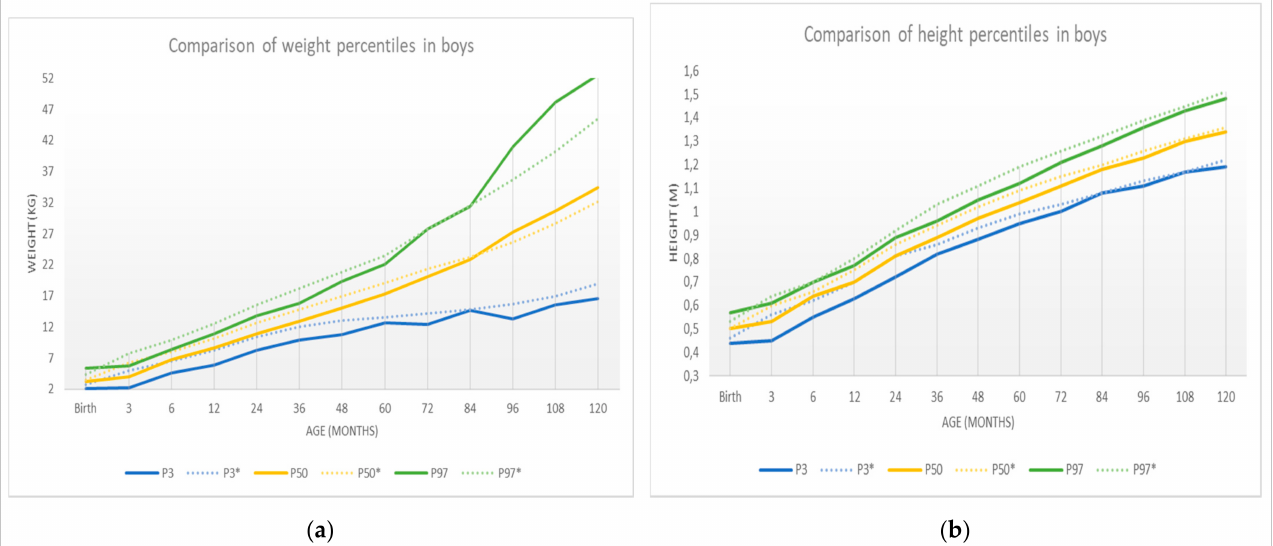
Figure 6. New specific curves for boys (solid) compared to the curves in [8] (dashed): ( a ) weight-specific curves; ( b ) height-specific